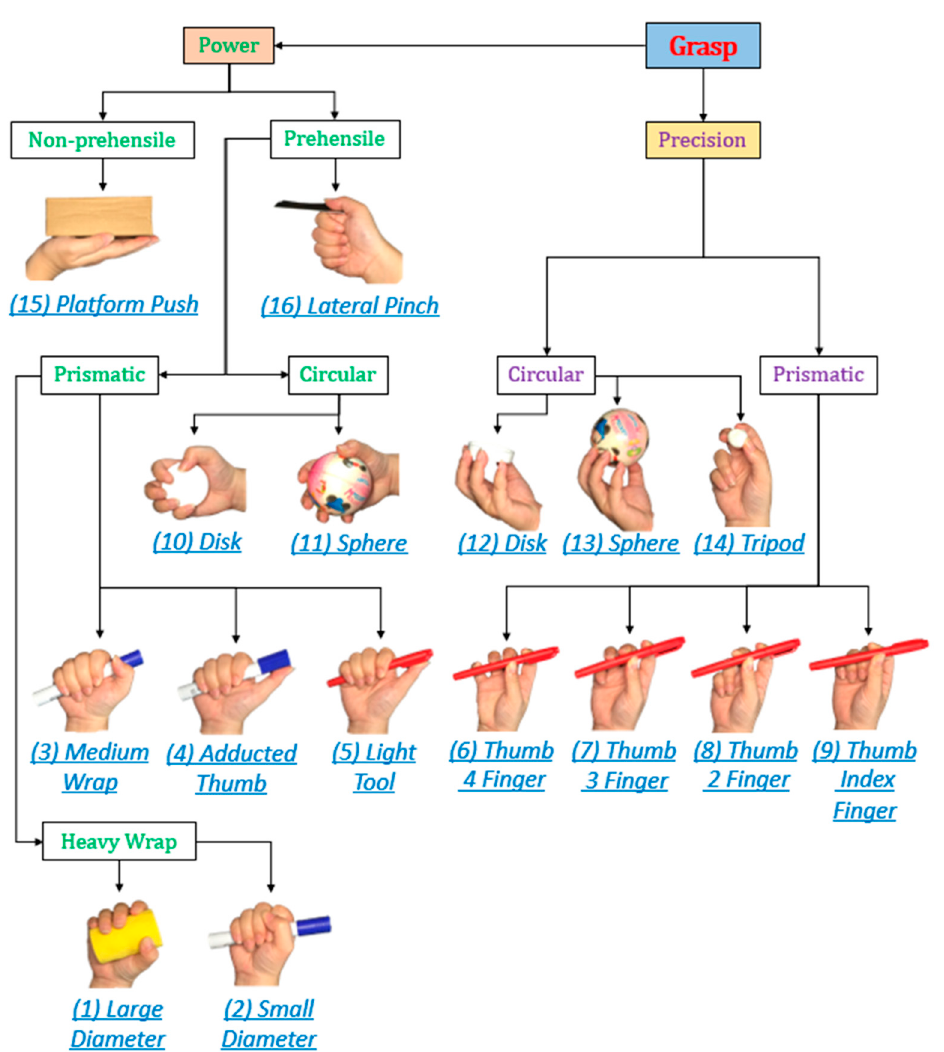
Figure 2. Cutkosky taxonomy (Adapted from [22], IEEE Trans. Robot. Autom. 1989 ). There are 16 hand motions divided into power and precision grasp, each motion labeled with successive numbers from bottom to top.